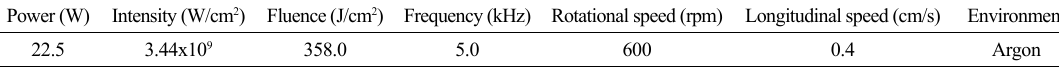
Figure 3. SEM micrographs with different magnifications of the surface modified by the laser Table 1. Parameters employed in the laser treatment.